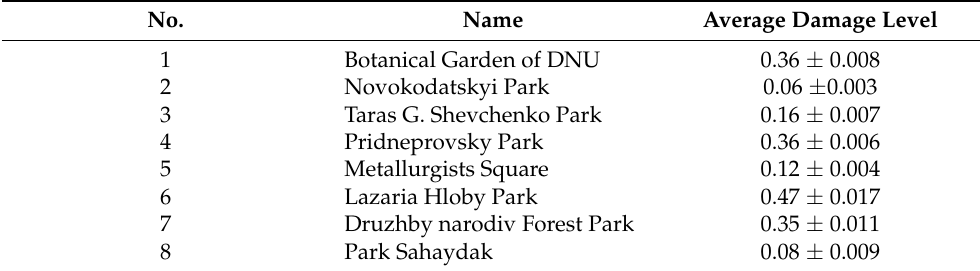
Table 3. Average damage level of Ae. hippocastanum leaf blades by C. ohridella miner (x ± SD, n = 40). No. Name Average Damage Level 1 Botanical Garden of DNU 0.36 ± 0.008 2 Novokodatskyi Park 0.06 ±